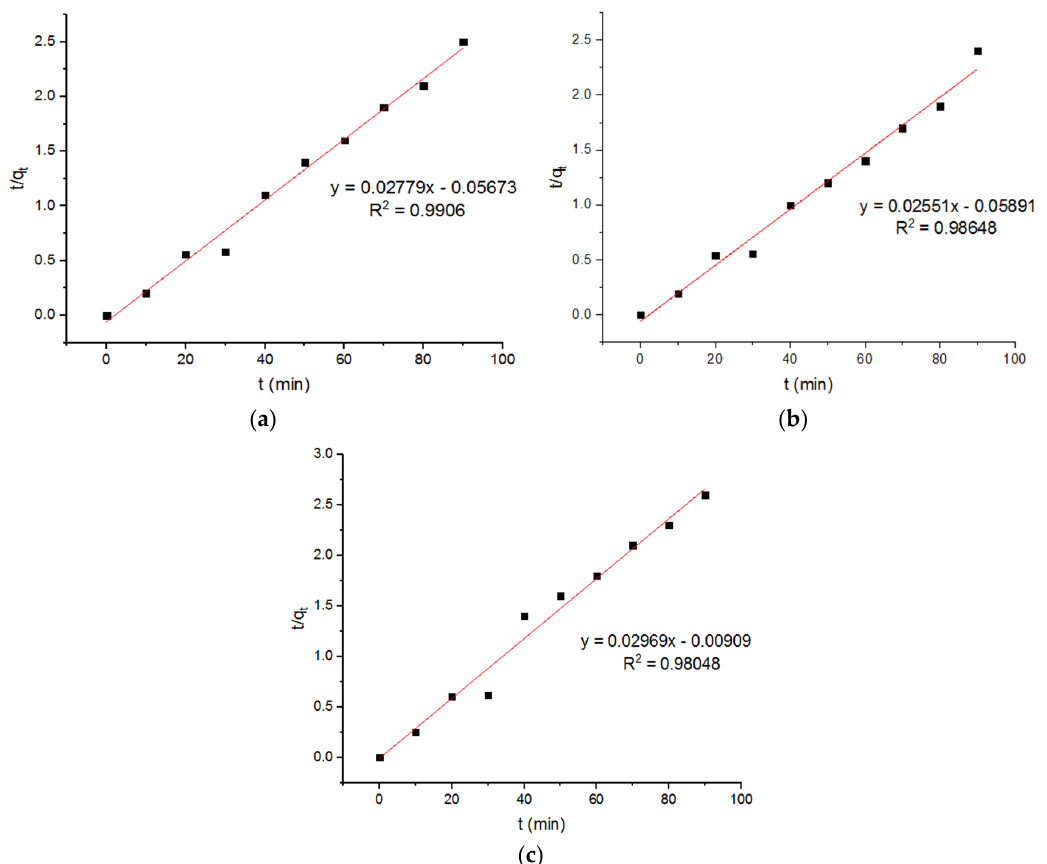
Figure 9. Pseudo-first-order plots for Pb 2+ adsorption onto MgFe 2 O 4 -NH 2 nanoparticles pre-func- tionalization-calcined at ( a ) 500 °C, ( b ) 600 °C, and ( c ) 700 °C.